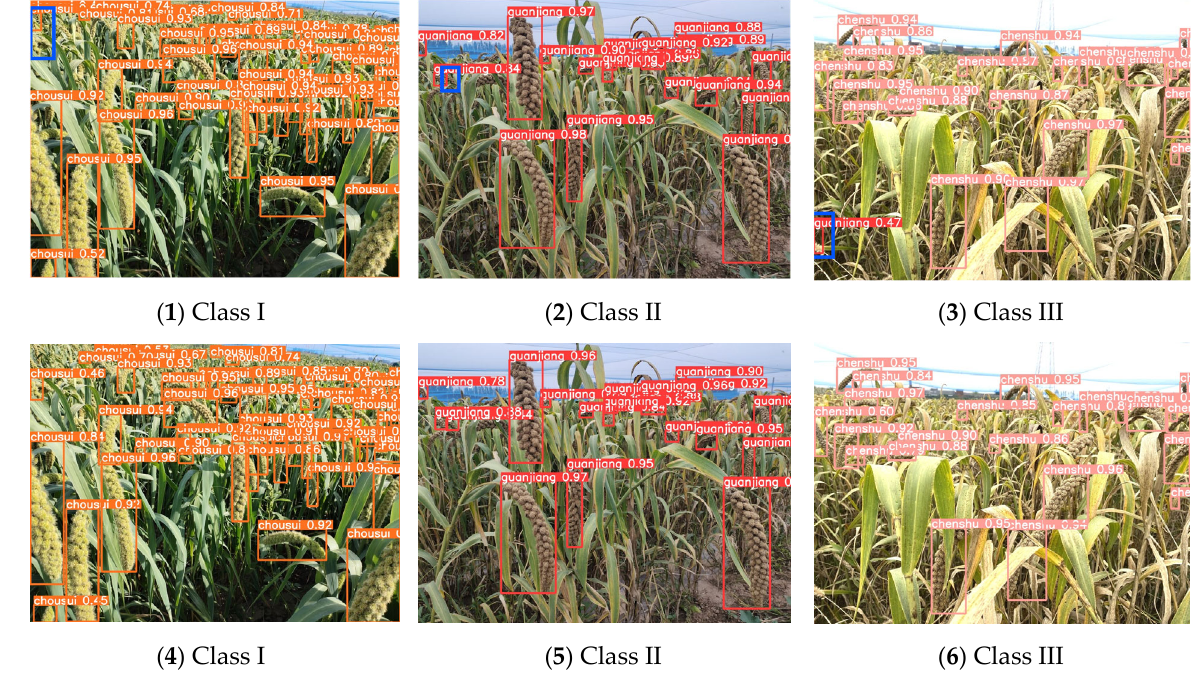
Figure 9. Detection of foxtail millet ears at different periods by the improved YOLOv5s model and the original YOLOv5s model.